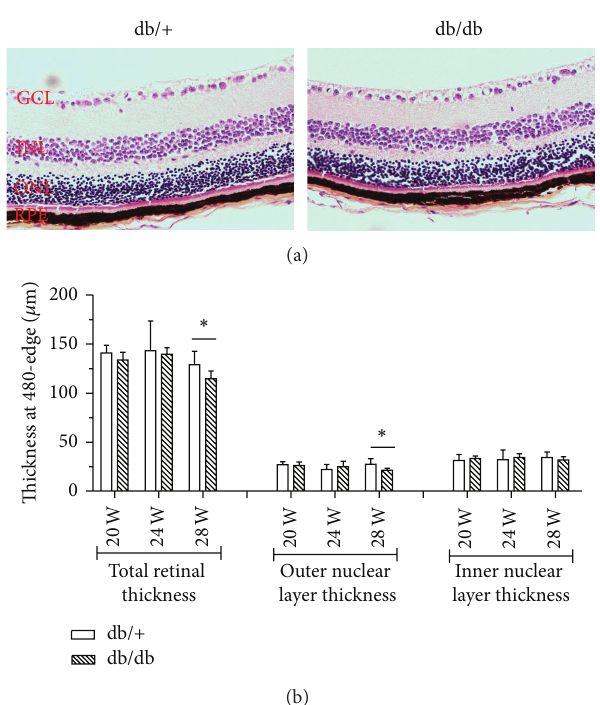
Figure 3: Hematoxylin and eosin stained retina (at 480 𝜇 m form ora serrata) in a representative case of a diabetic mouse (upper panel) and a nondiabetic mouse (lower panel) of 28 weeks of age (a). Thickness of total retina, outer nuclear layer, and inner nuclear layer (b). Results are expressed as mean ±